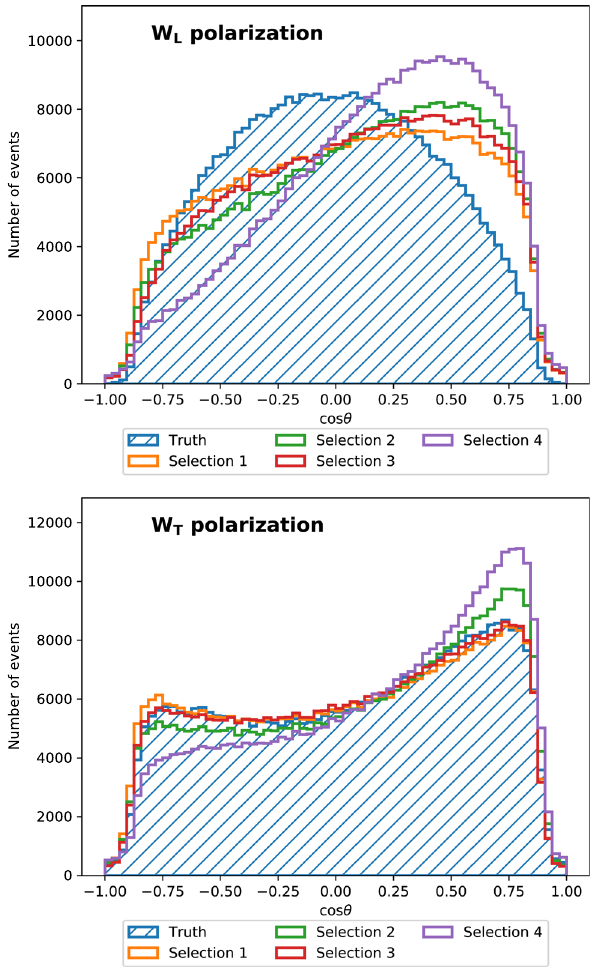
Fig. 3 Shape of the reconstructed lepton angular distribution in the reconstructed W boson rest frame. Parton-level (truth) distributions are shown for comparison, using the generator-level (true) cos ϑ . The top plot shows results obtained assuming the purely longitudinal (W L ) and the bottom plot the purely transverse (W T ) scenario. Selection criteria 1–4, have been studied as strategies for choosing the correct solution, as described in the text